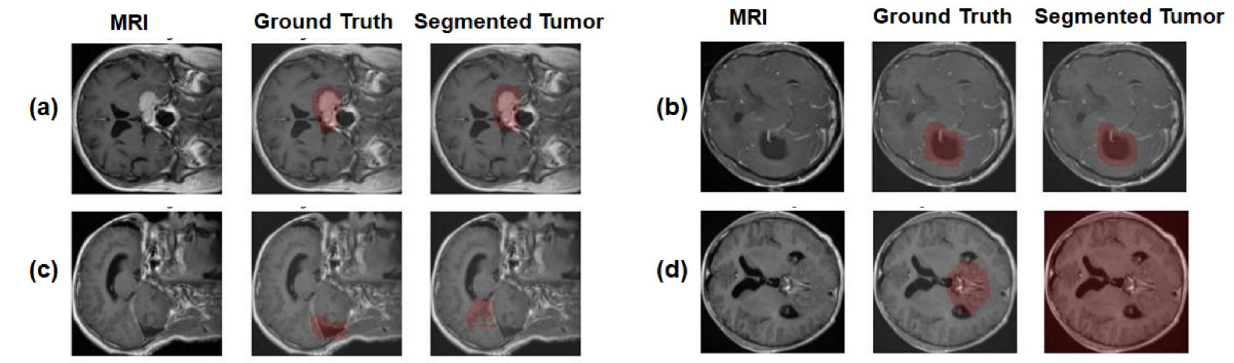
Fig 27. Sample segmentation outputs for 2D U-Net++ segmentation.